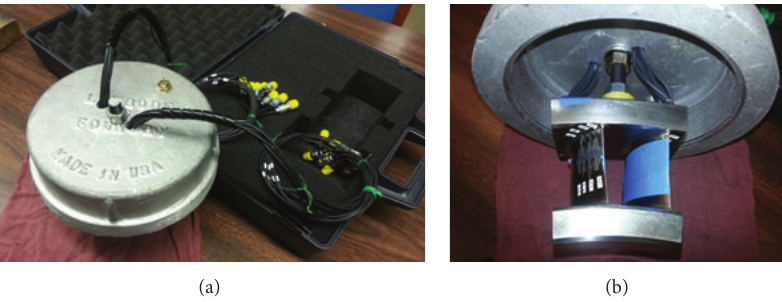
Figure 8: Calibration chamber setup for the vane-mounted pressure transducers.